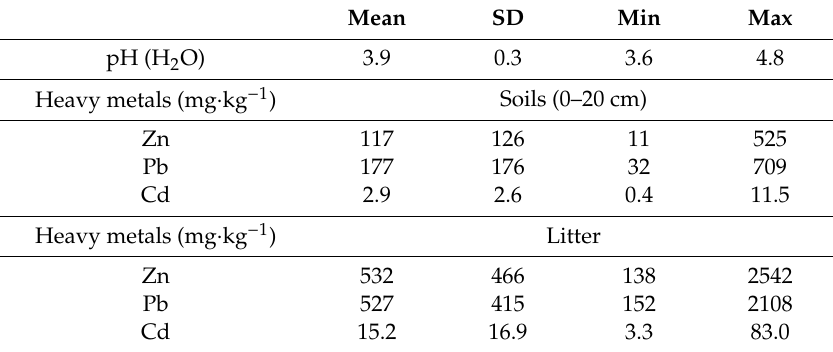
Table 1. Basic statistics of pH, Zn, Pb, and Cd concentrations (mg · kg − 1 ) in soil and litter from study area.